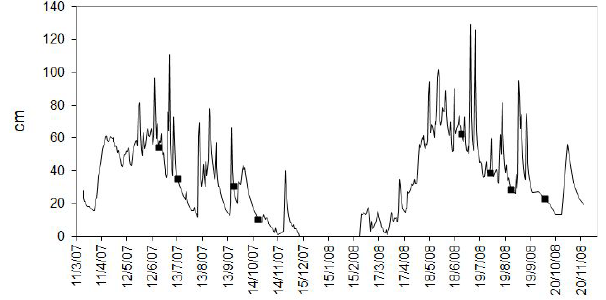
Table 1. Land cover categories used to characterize the study basin.